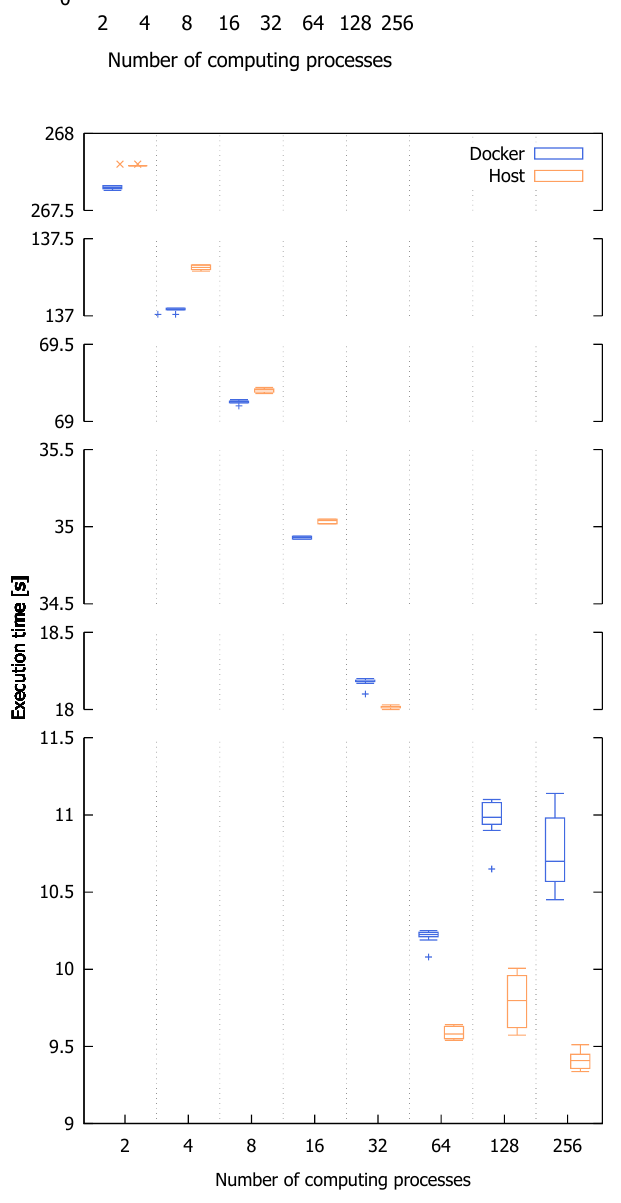
Figure 2. Execution times for DAC, -O3 compilation flag; boxplot notation: medians, Q1 and Q3, max(Q1 − 1.5IQR, minimum) and min(Q3+1.5IQR, maximum) as well as potential outliers (+ for Docker, x for